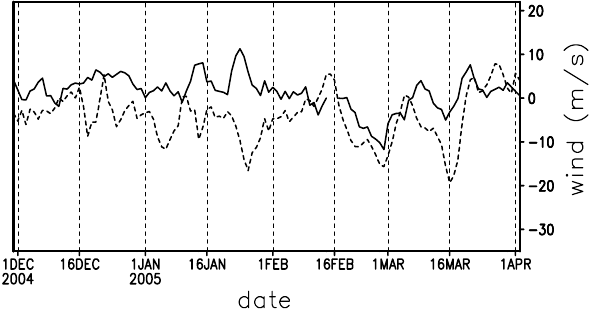
Fig. 16. Time sequences of meridional winds at 88km over Rothera (68 ◦ S, 292 ◦ E) (solid line) and over Saskatoon (52 ◦ N, 253 ◦ E) (dashed line) in winter